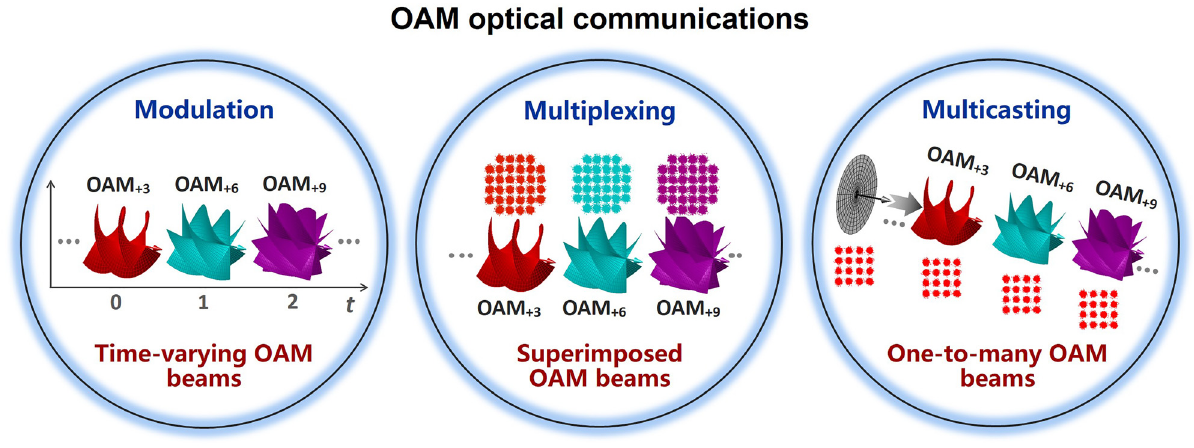
Figure 4: Different types of OAM optical communications (OAM modulation, OAM multiplexing, OAM